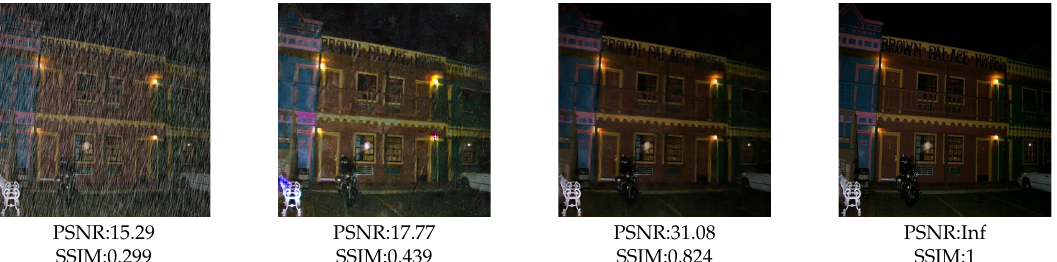
Figure 7. An example of comparison between batch normalization and instance normalization. From left to right: input, using batch normalization, using instance normalization, ground truth.Reproduced with permission from Li et al. [13], published by 2019 IEEE International Conference on Multimedia and Expo (ICME).